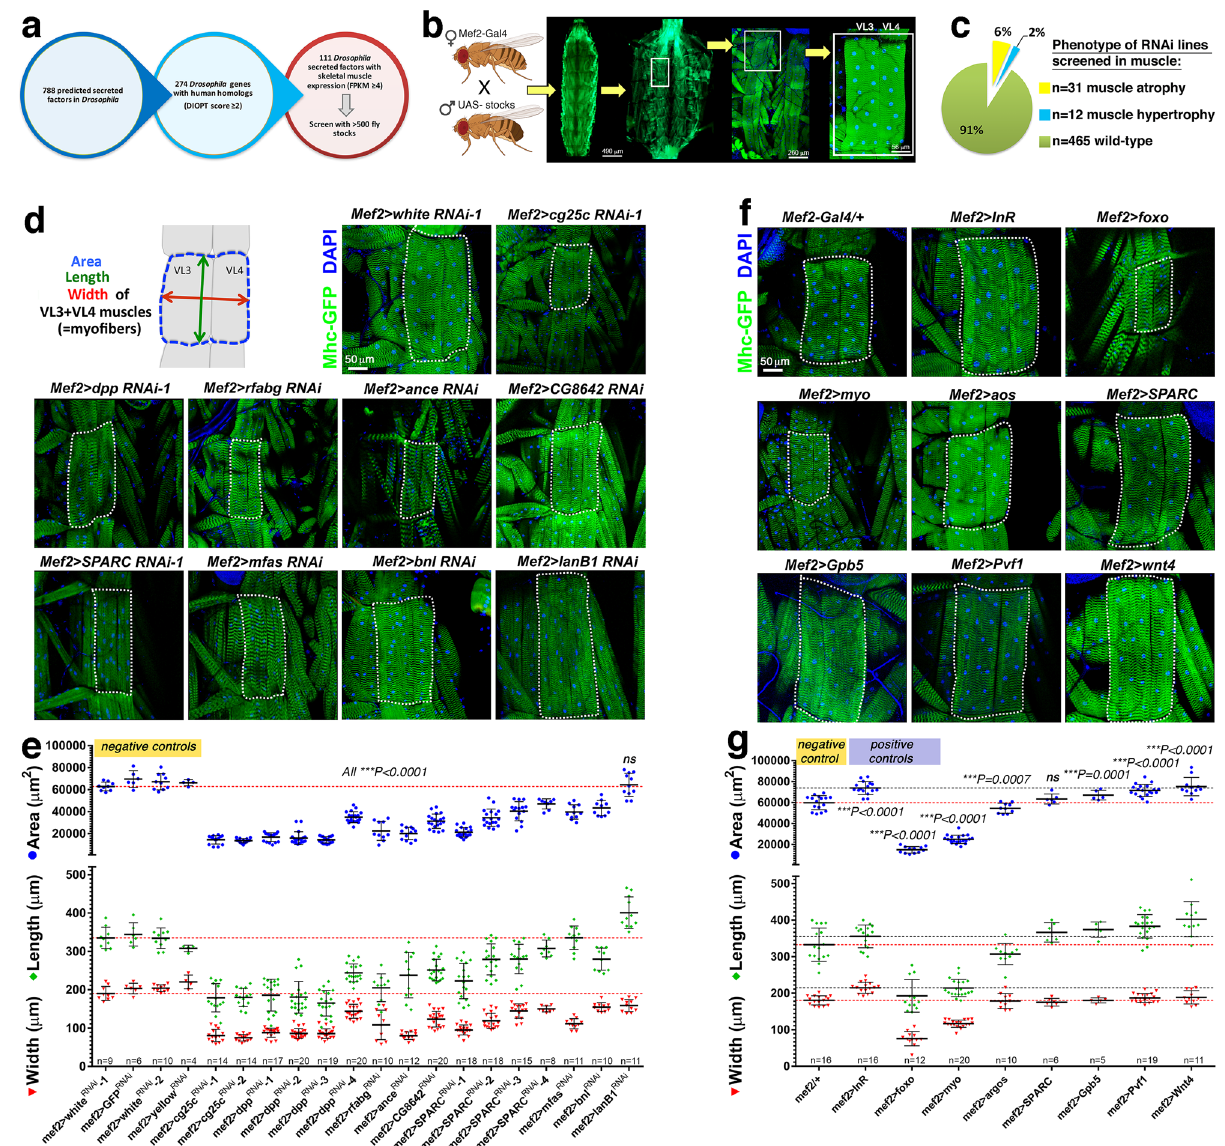
Fig. 1 RNAi and overexpression screening identi fi es myokines that regulate myo fi ber size in Drosophila body wall skeletal muscles. a Starting from 788 predicted secreted factors encoded by the Drosophila genome, 274 with human homology were selected based on a DIOPT homology score of ≥ 2. Of these, 111 secreted factors with substantial skeletal muscle expression (FPKM ≥ 4) were further chosen for screening with the UAS/Gal4 system and 508 transgenic stocks. b Transgenic RNAi or overexpression was driven in body wall skeletal muscle with Mef2-Gal4 and muscle phenotypes were identi fi ed fi rst based on overall larval body size and secondarily with dissections and analysis of the size of a stereotypical set of skeletal muscles, ventral longitudinal VL3 and VL4 muscles, each consisting of a single myo fi ber. c Screen results (see Supplementary Data 1 for a full report): 31 interventions induced myo fi ber atrophy (6.1%), 12 led to myo fi ber hypertrophy (2.4%), whereas 465 led to no phenotype (91.5%). d Representative images of RNAi interventions that induce myo fi ber atrophy, compared to negative control RNAi. e Quantitation of the myo fi ber area, width, and length indicates a signi fi cant decrease; mean values ± SD and the precise n(VL3 + VL4 muscles from independent larvae) are reported in the fi gure; P < 0.001. Statistical analysis was done by using two-way ANOVA with Dunnett ’ s multiple comparison test. f Representative images of muscle size phenotypes induced by myokine overexpression, compared to a negative control ( + ; no transgene) and to positive controls ( foxo and Insulin Receptor overexpression). g Quantitation of the myo fi ber area, width, and length indicates the signi fi cant induction of myo fi ber atrophy and hypertrophy by overexpression of the myokines indicated; mean values ± SD; the n(VL3 + VL4 muscles from independent larvae) is reported in the fi gure; P < 0.001. Statistical analysis was done by using two-way ANOVA with Dunnett ’ s multiple comparison test. Source data and complete statistical analyses are provided in the Source Data fi